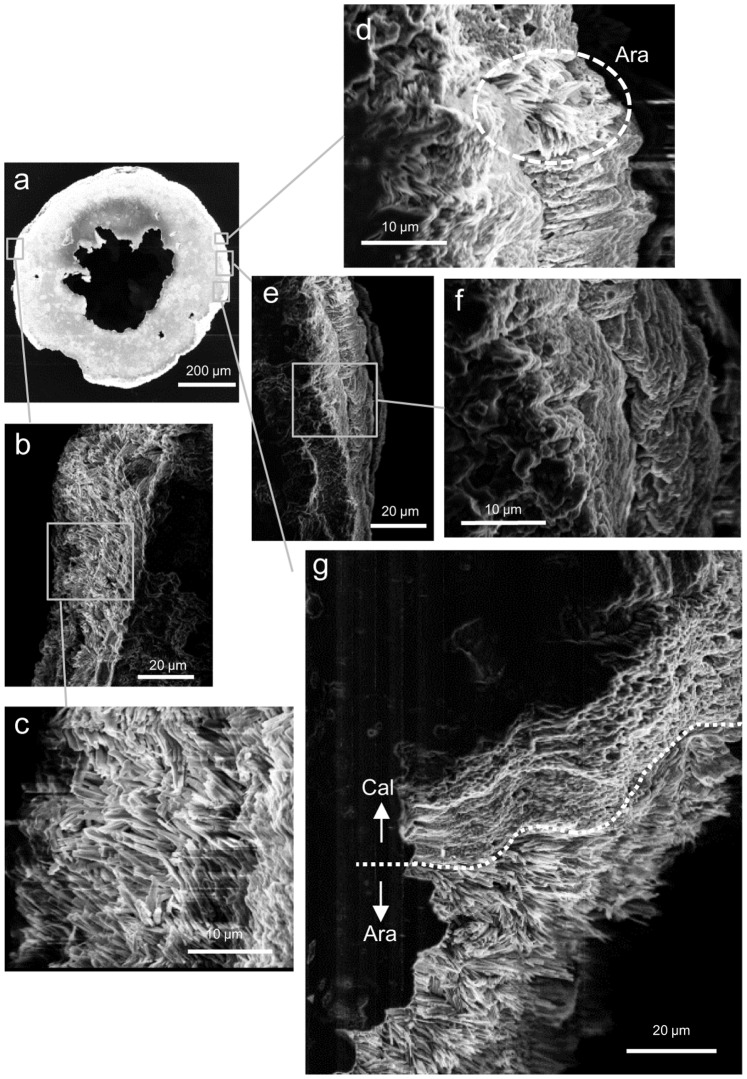
Scanning electron microscope (SEM) images corresponding to Figure 2e (mMg/Ca = 0.5).(a) Whole juvenile skeleton (×100); (b) aragonite (×1000); (c) aragonite (×3000); (d) aragonite and calcite (×3000); (e) calcite (×1000); (f) calcite (×3000); (g) aragonite (underside of juvenile coral) and calcite (upper side of juvenile coral) (×1000). The crystal structures were determined by Raman spectroscopy (Figure 2e).